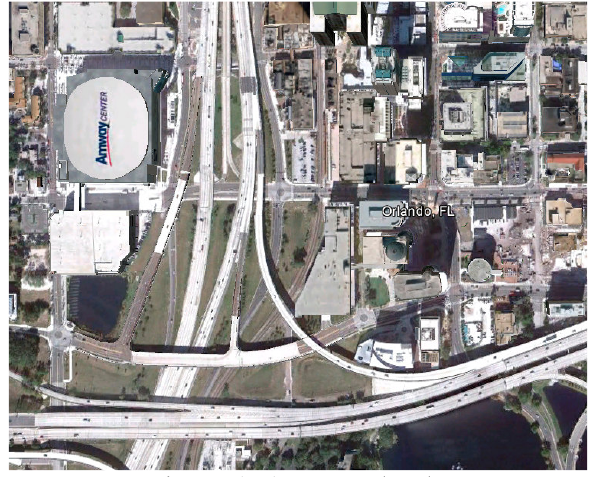
Figure 1. A true orthophoto